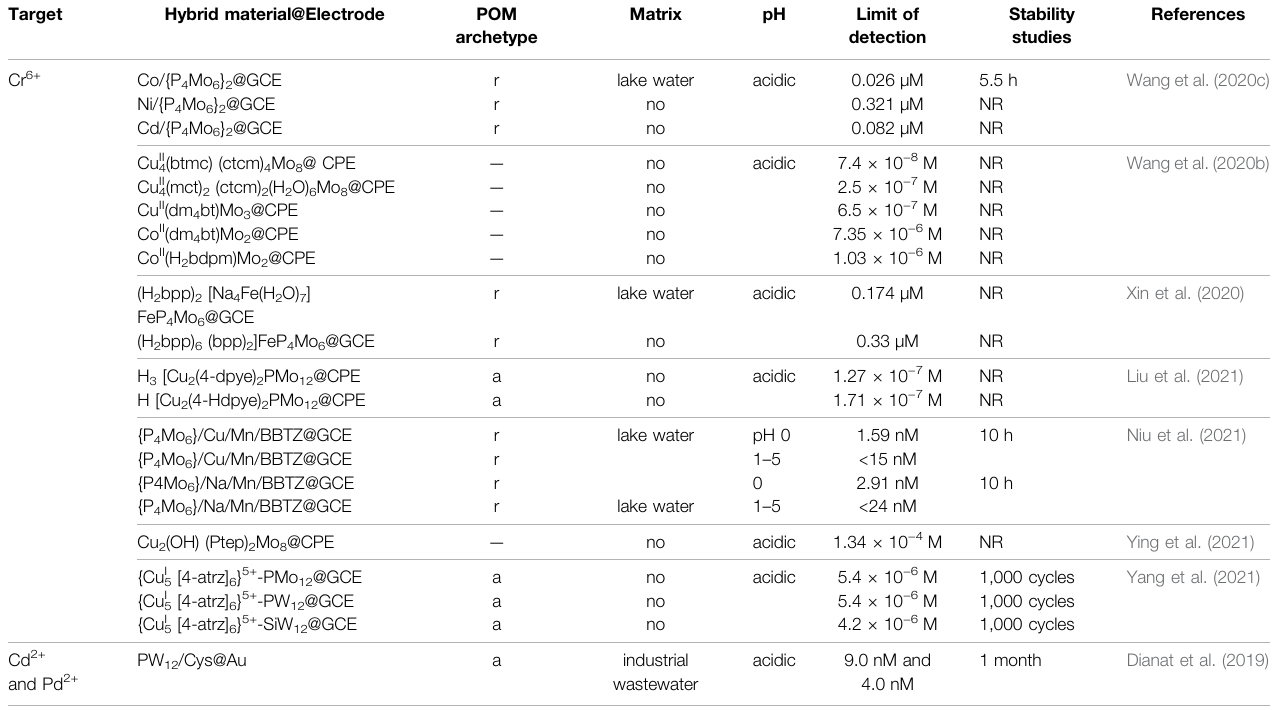
TABLE 6 | POM-based electrochemical sensors for metal ions.